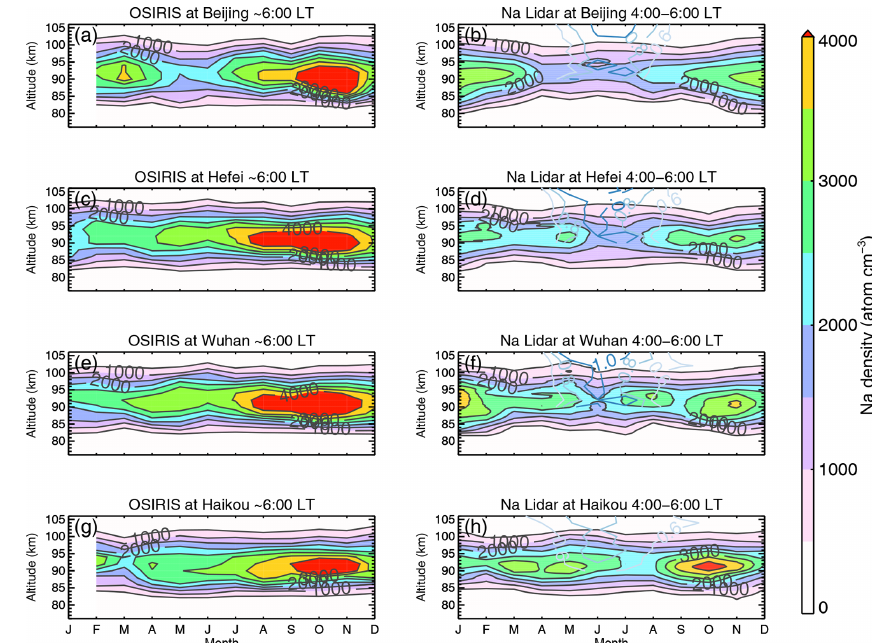
Figure 10. Comparisons of monthly mean of Na number density in the morning, from OSIRIS at about 06:00LT (descending node) and Na lidars at 04:00–06:00LT (a–b) at Beijing, (c–d) Hefei, (e–f) Wuhan, and (g–h) Haikou. The summer maximum E s layers represented by S4max at levels of 0.6, 0.8, and 1.0 are shown as light to dark blue contour lines, superposed on the Na density contour from lidars on the right